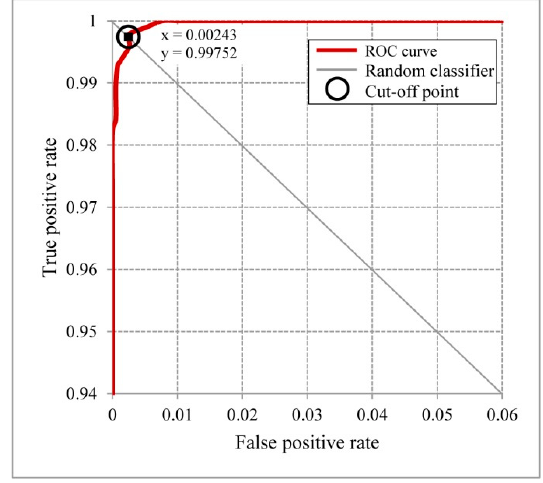
Figure 28. Zoomed-in Receiver Operating Characteristics (ROC) curve, where the square mark in the circle represents the cut-off point.